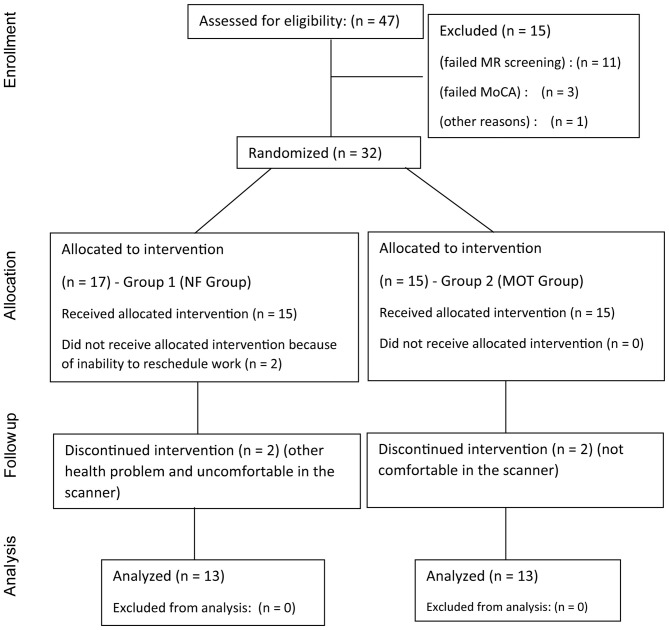
The CONSORT diagram shows the flow of patients through each stage of the randomized, controlled trial.